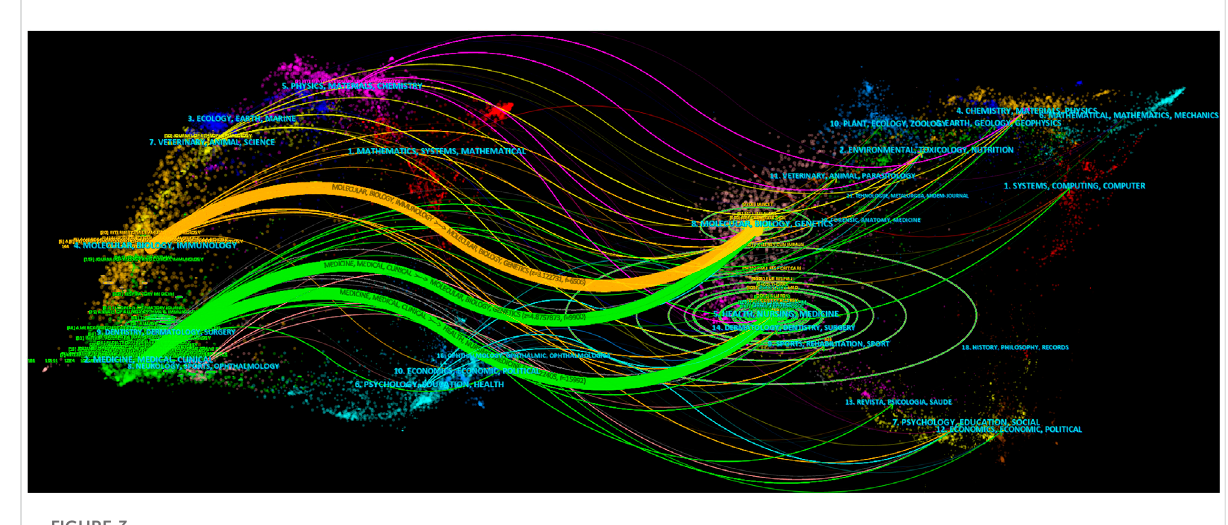
FIGURE 3 Dual-map overlay of journals on asthma drug-related studies. Notes: label top N journal: 50, font size: 8, a: 3, source circle size: 200, target circle size: 8, and snap to centroids ( < radius):